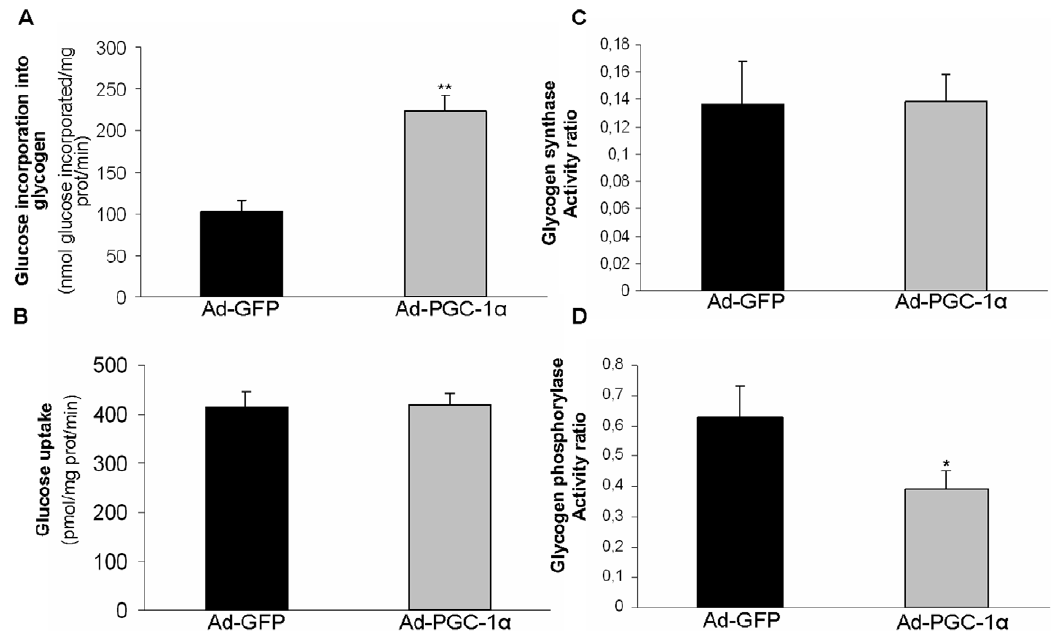
Figure 6. Effect of PGC-1 a -overexpression on glycogen metabolism and glucose uptake in cultured muscle cells. Cultured skm cells were transduced with Ad-GFP or Ad-PGC-1 a . (A) Cells were incubated with 10 mM [U- 14 C]-glucose (0.10 m Ci/ m mol) for 18 h and then harvested to asses glucose incorporation into glycogen. Data are means 6 SEM from two experiments performed in triplicate. (B) Glucose uptake was measured using 0.5 mM 2-deoxy-D-[ 3 H]glucose (0.5 m Ci/well). Data are means 6 SEM from two experiments performed in triplicate. (C,D) Cells were harvested to measure (C) glycogen synthase and (D) glycogen phosphorylase activity. Data are means 6 SEM from three experiments performed in quadruplicate. The significance of differences versus cells treated with control adenoviruses is indicated as follows: *p , 0.05 and **p ,